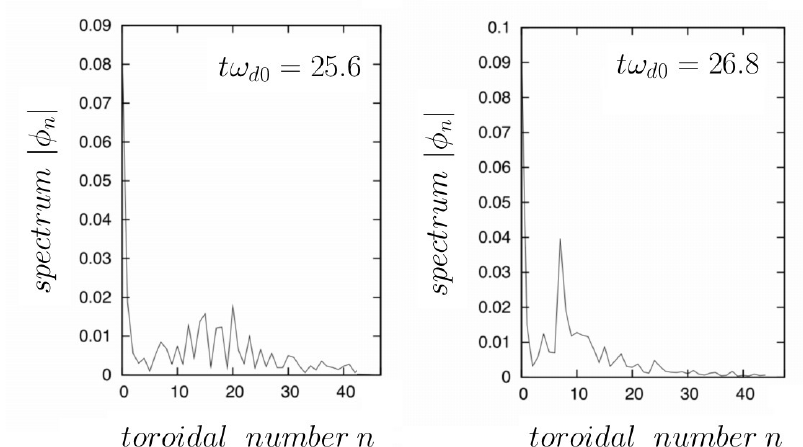
Figure 10. Spectra in wave-numbers, i.e., in toroidal numbers. The spectra reveal the occurrence of (nonlinear) streamers with a broad spectrum (with a toroidal number of n ∼ 16–24) as can be seen on the plot shown at time t ω d 0 =